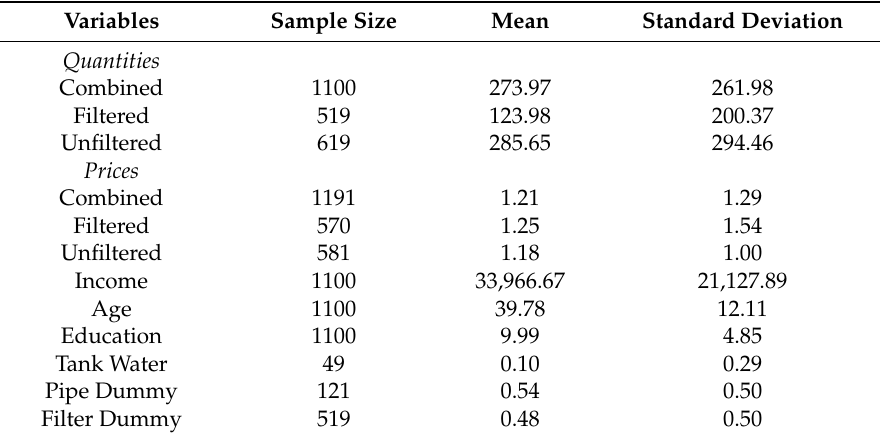
Table A2. Summary statistics of variables.